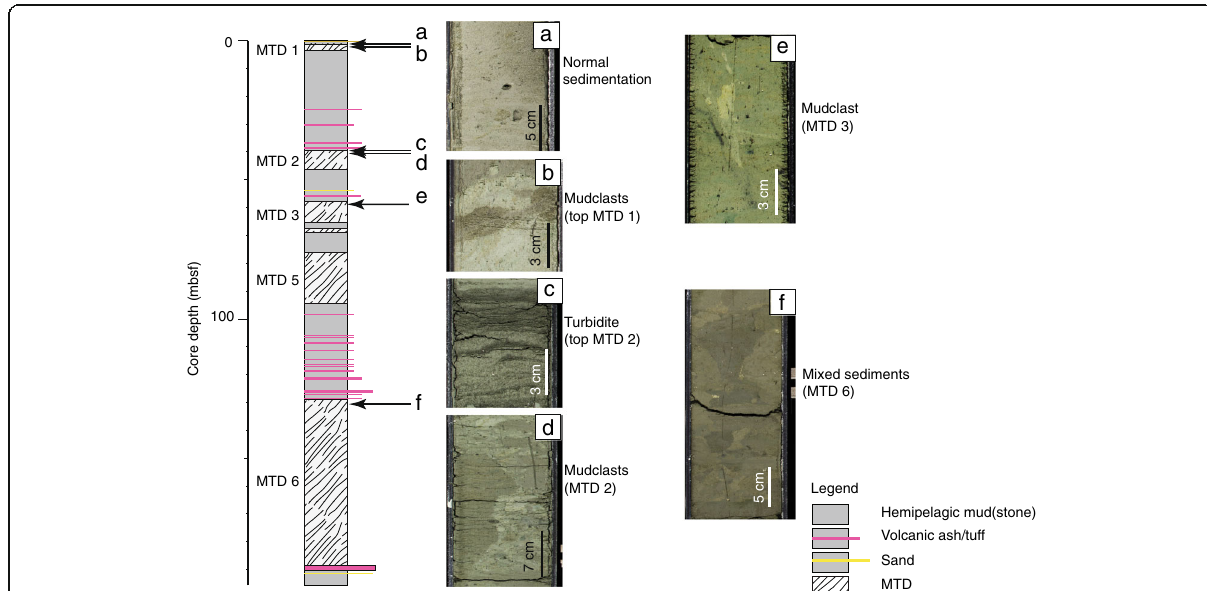
Fig. 4 Examples of sedimentological features of the hemipelagic sediment ( a ) and of various parts of the MTDs (such as mudclasts in b , d and e ; turbidites in c and mixed sediments in f )